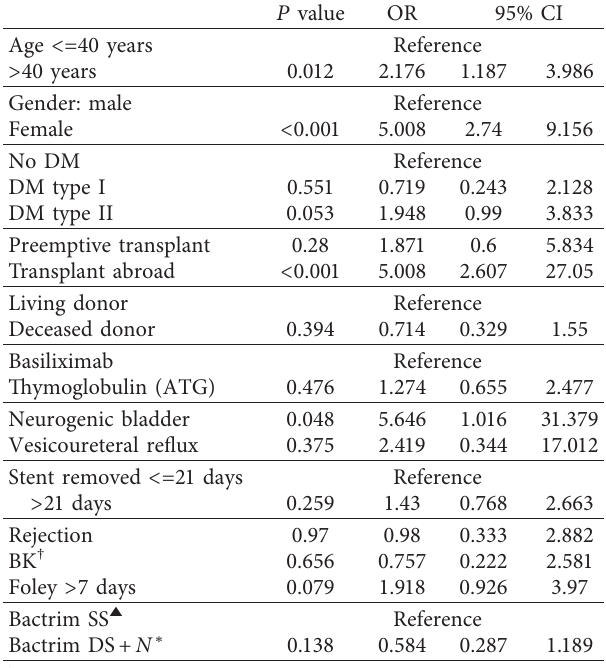
Table 3: Predictors of first UTI after renal